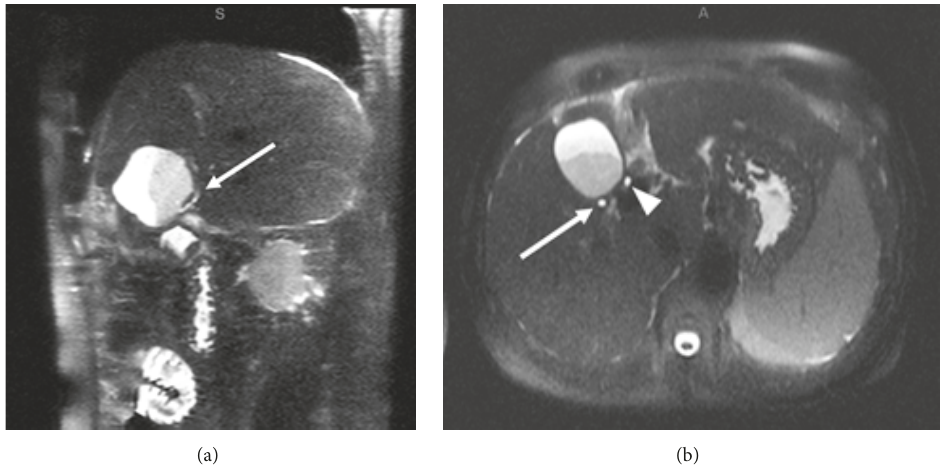
Figure 3: Postoperative thin slice MRCP images in sagittal (a) and axial (b) planes. Fluid collection with layering debris is present in the gallbladder fossa. (a) The cholecystohepatic duct terminates within the collection, entering posteriorly (arrow). (b) More superiorly, the duct is again seen posterior to the fluid collection (arrow). It is in a similar location compared to the preoperative imaging, but slightly more dilated. The common hepatic duct is also seen more medially